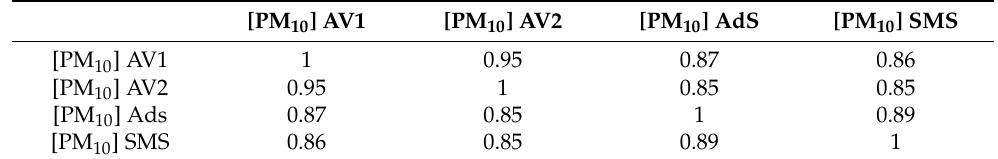
Table 3. Pearson correlations of PM 2.5 and PM 10 , for AV1, AV2 and two AURA monitoring stations (Aiello del Sabato and San Michele di Serino) during September 2021 ( p < 0.005).